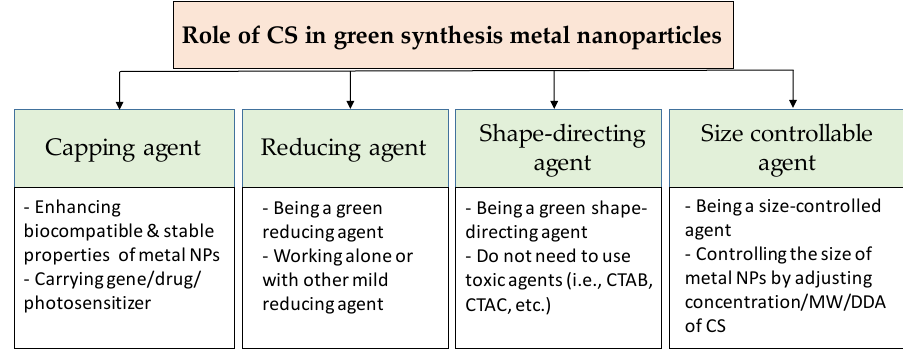
Figure 2. Overview of the role of chitosan in green synthesis of metal nanoparticles.